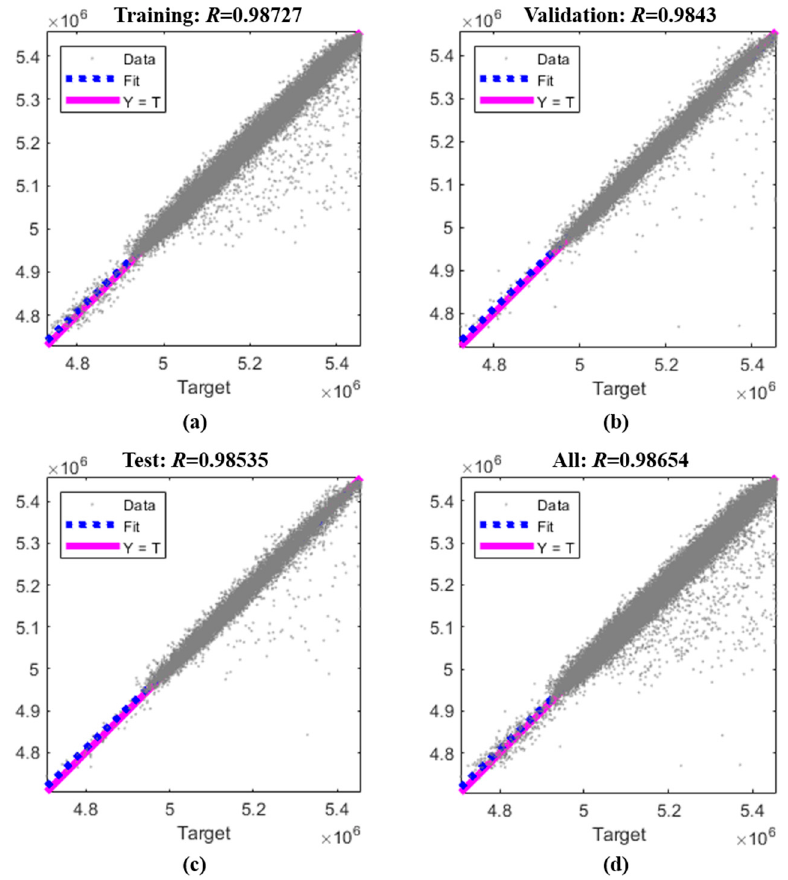
Figure 8. Correlation coefficients of ( a ) training, ( b ) validation, ( c ) test, and ( d ) all data set.